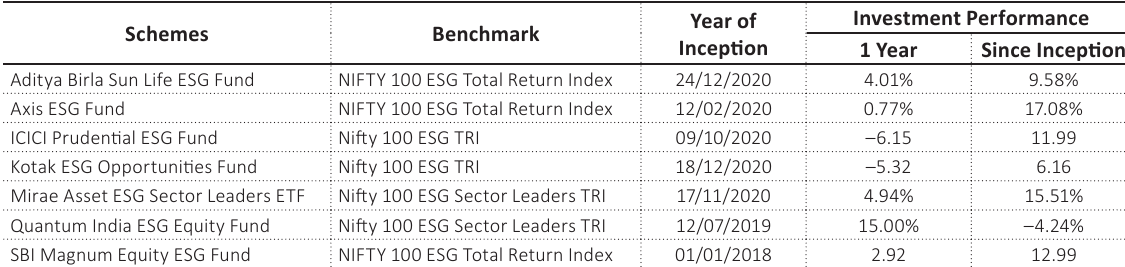
Table 2. Mutual fund schemes tracking NIFTY 100 ESG indices